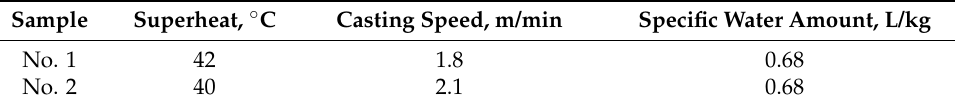
Table 1. Main process parameters of SCM440 cold heading steel billet.